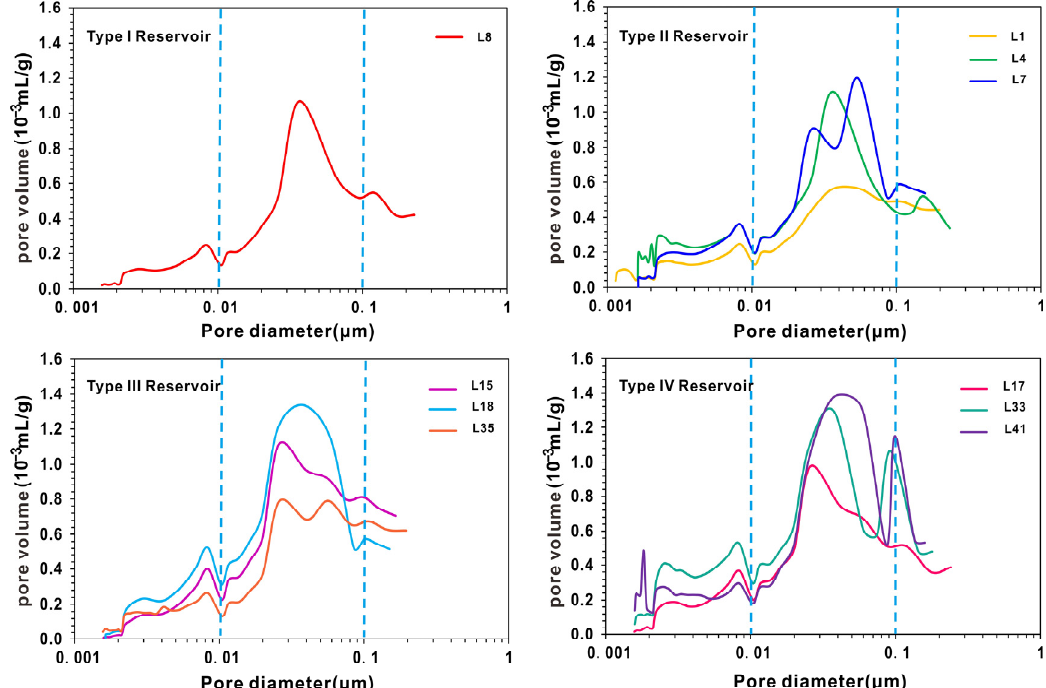
Figure 12. BJH pore size distribution of shale oil samples.